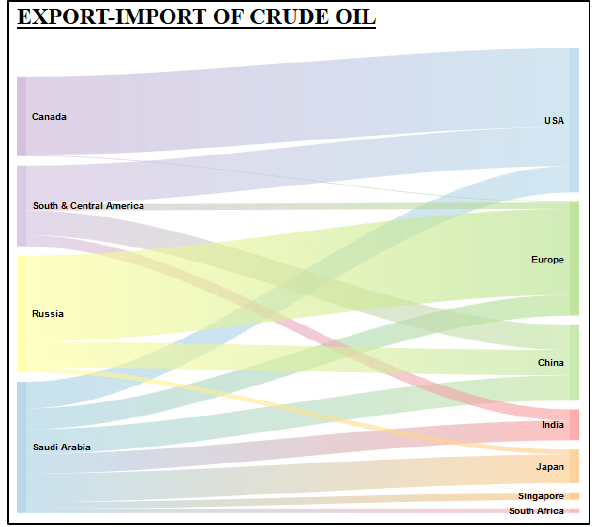
Figure 8. Major importers of crude oil Saudi Arabia is the single largest country that exports crude oil. The geospatial distribution of these exports are graphically depicted in Figure 9 in form of a Sankey Diagram. The thickness of the arrows depict relative quantum of export of crude oil. Figure 9 reveals that major quantum of export is to USA, China, Japan, European nations and India. Less quantum of exports are towards Canada, South Africa and South and Central America. This is evident because, these nations have their own resources of crude